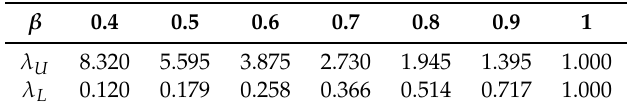
Table 3. Two local decision thresholds λ U and λ L for snr L = 5 dB.